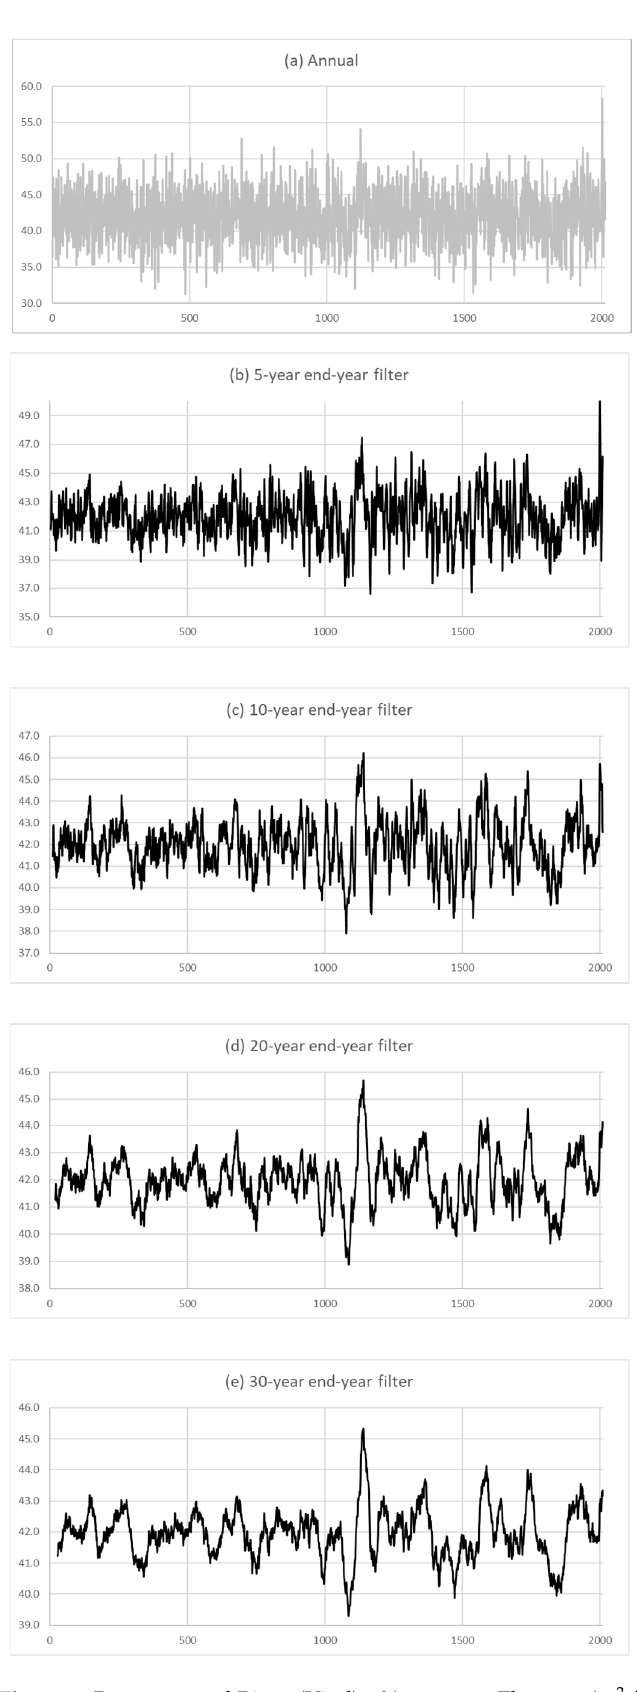
Figure 6. Reconstructed Rienz (Vintl)—Year versus Flowrate (m 3 /s) from 0 to 2012 AD for ( a )